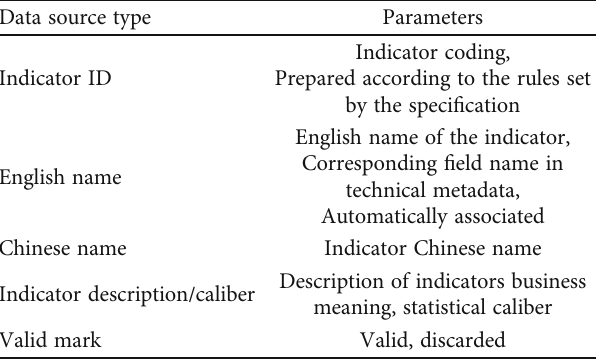
Table 1: CPIM format data element